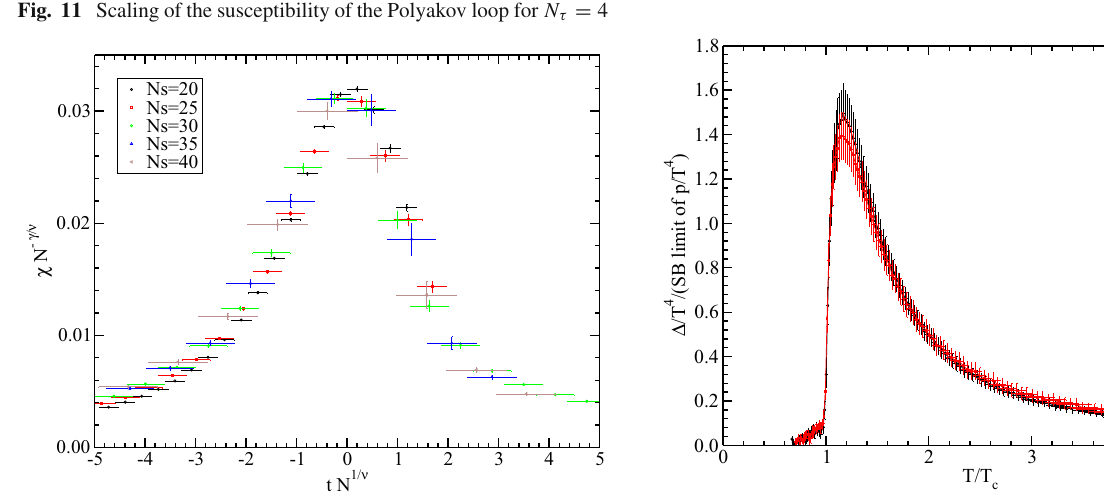
Fig. 12 Scaling of the susceptibility of the Polyakov loop for N τ = 5